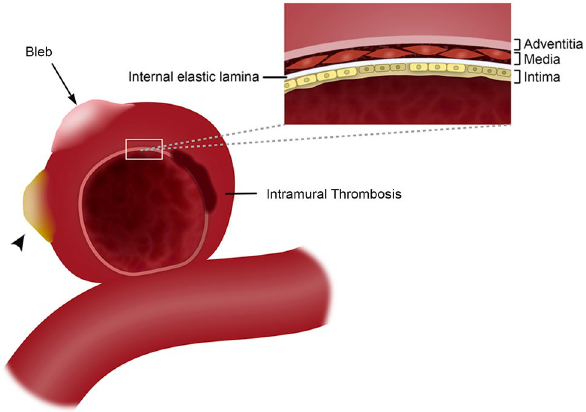
Figure 1. Vessel wall layers of an intracranial aneurysm with a bleb (arrow) and atherosclerotic calcification (arrowhead). The aneurysm wall has a complex morphology with multiple biological processes. This image belongs to the author Edgar A